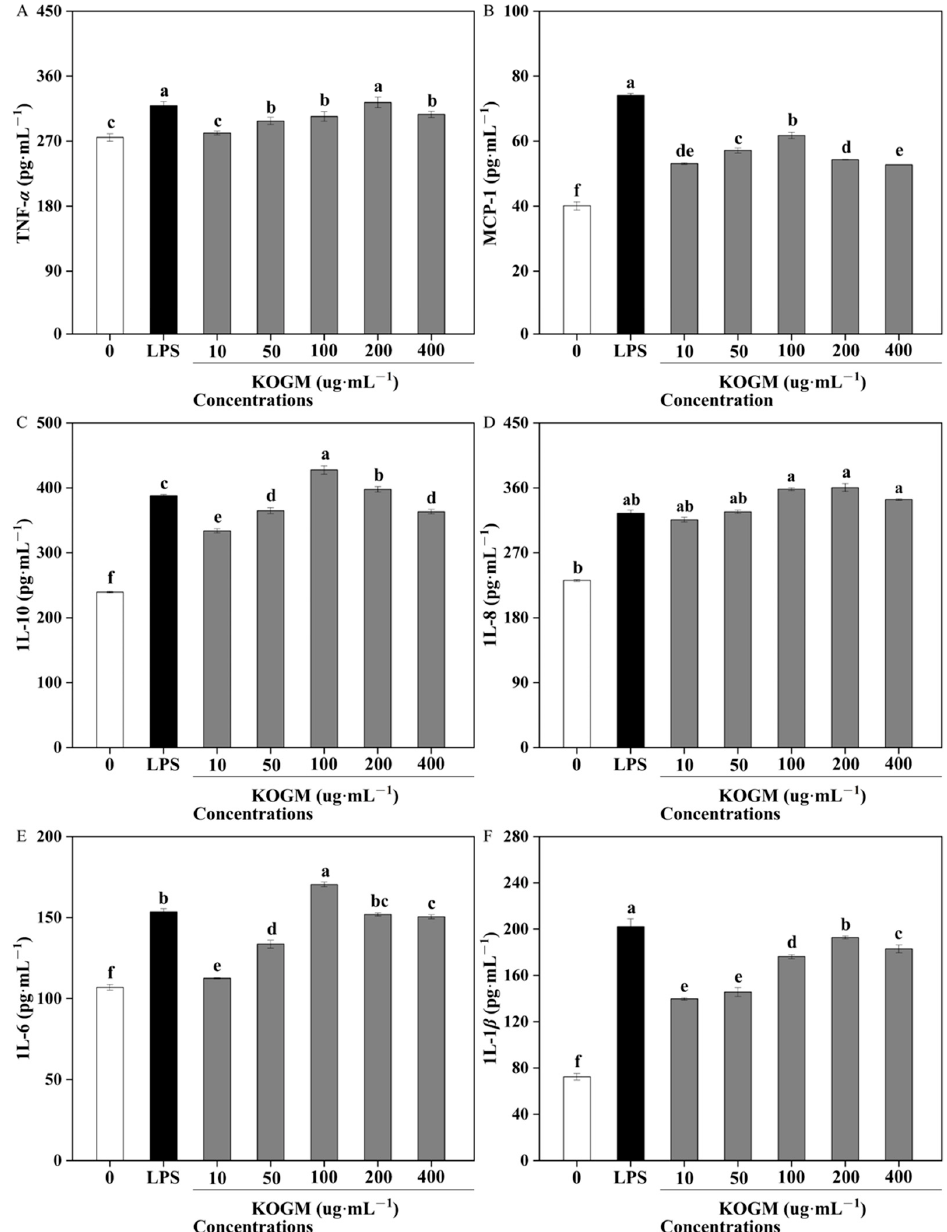
Figure 9. Effects of W. cibaria F1 mannanase on production of cytokine of RAW264.7 macrophages in vitro . Different letters in superscript donate significant difference ( p < 0.05).